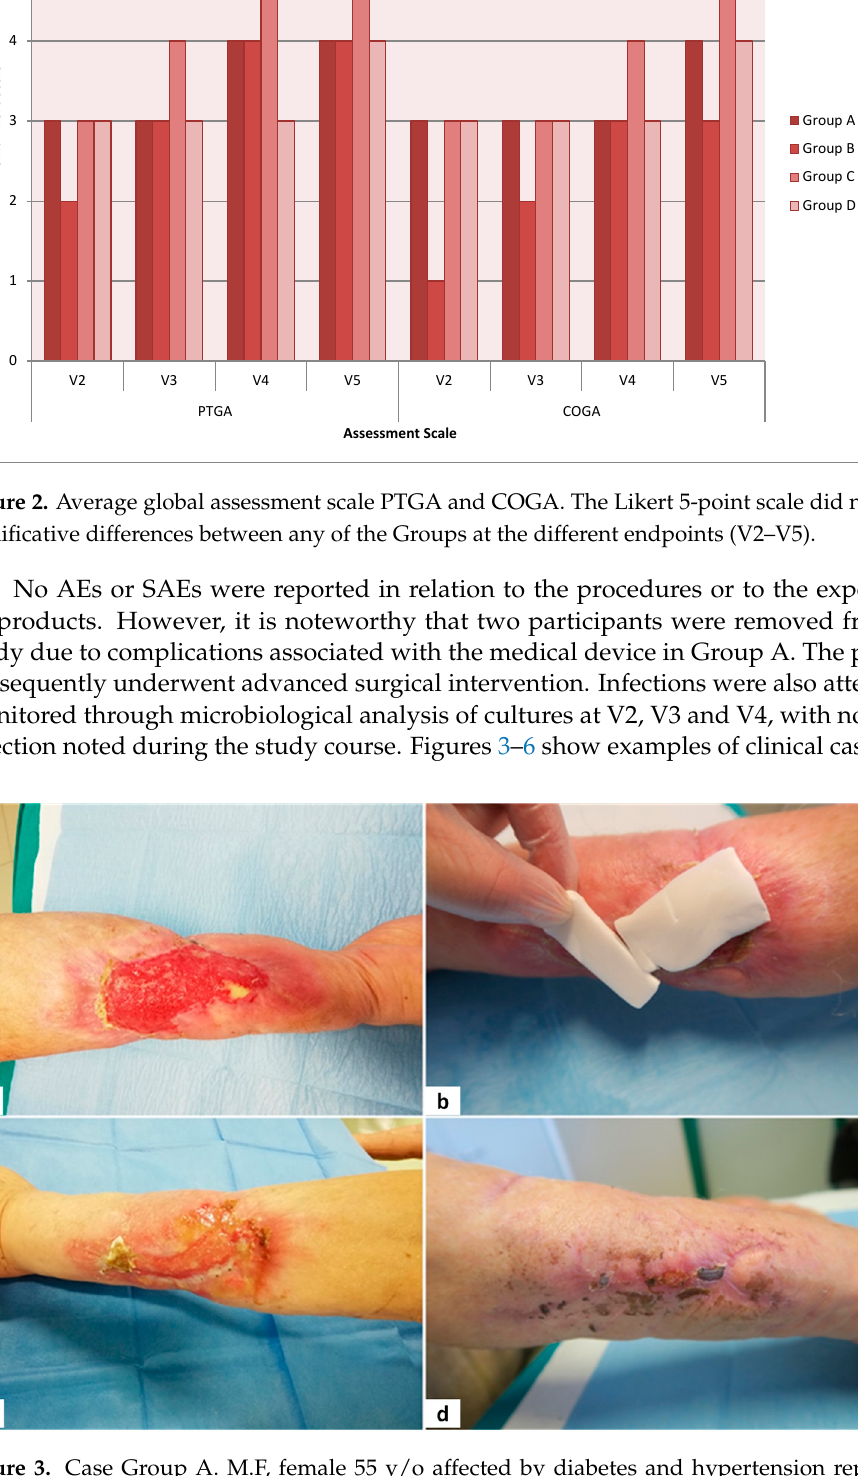
Figure 3. Case Group A. M.F, female 55 y/o affected by diabetes and hypertension reported a post-traumatic chronic wound in the dorsal part of the right arm close to the elbow ( a ). The aspect of the wound at V1 and the application of collagen plates enriched with hyaluronic acid ( b ). The wound aspect at V3 ( c ). The final aspect at V5 ( d